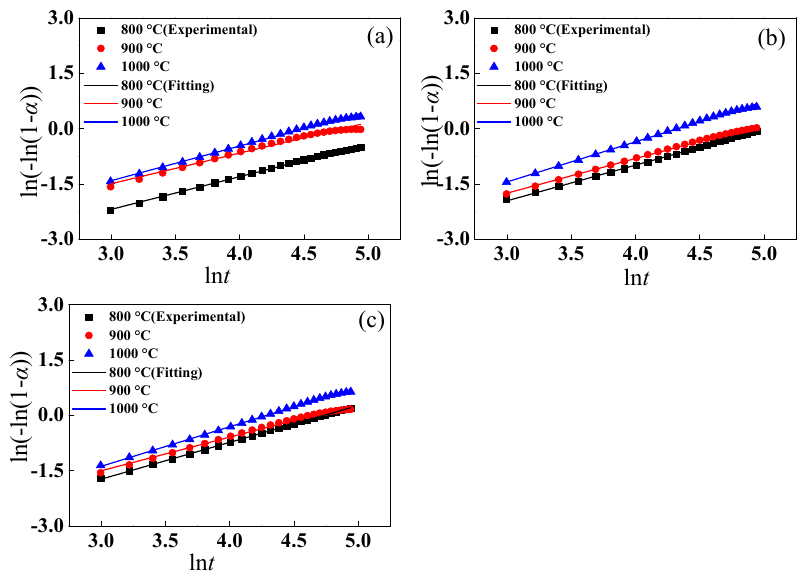
Figure 11. Plot of ln( − ln(1 − α )) vs. ln t for di ff erent raw materials ( a ) 2.0 wt%;( b ) 1.7 wt%;( c ) 1.3 wt%. Table 4. Slope of linear fitting and R 2.